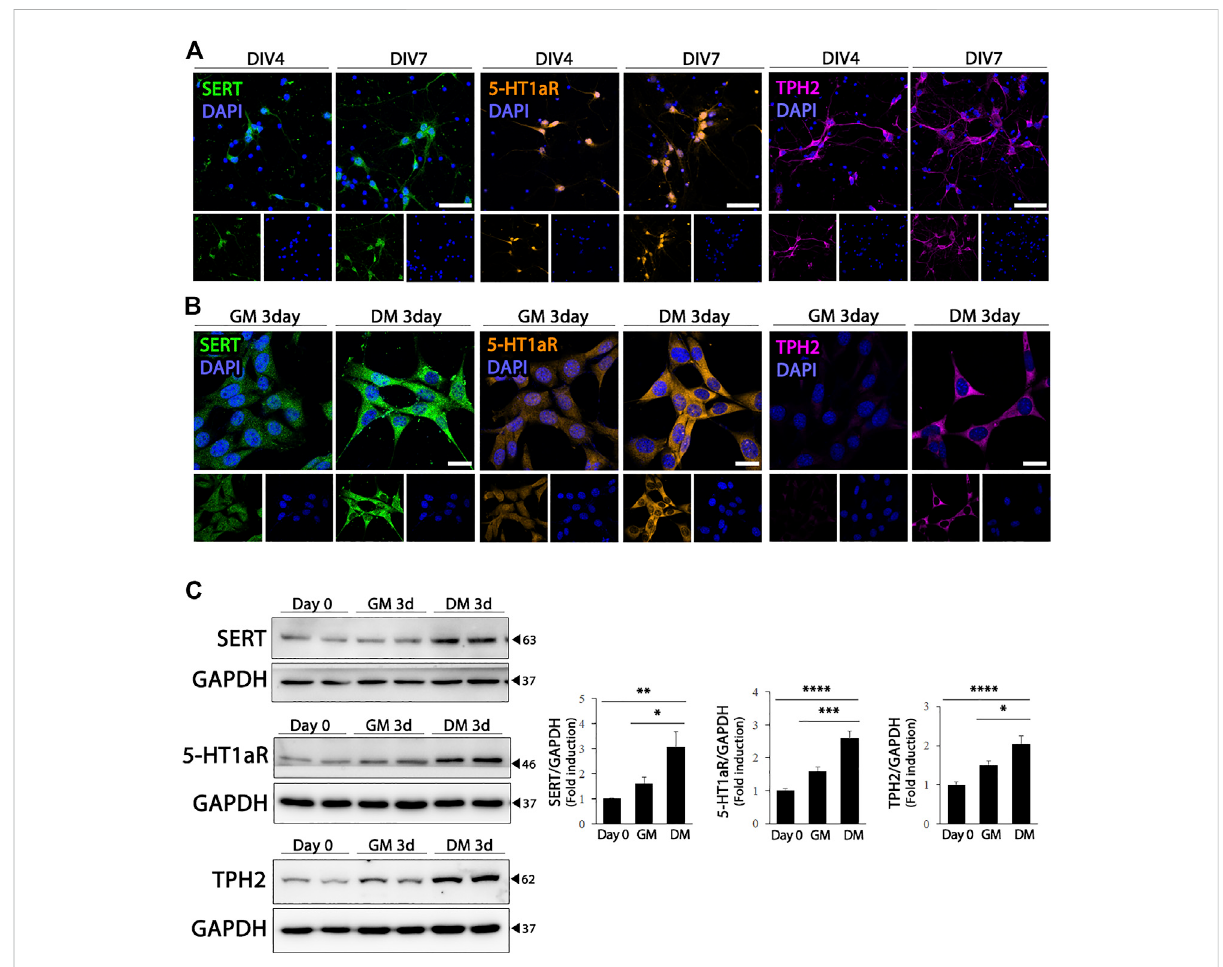
FIGURE 2 Enhanced serotonergicphenotypes ofdifferentiatedHT22 cells. (A) Immuno fl uorescence stainingofSERT(green),5-HT 1a R(orange)andTPH2 (magenta) in hippocampal primary culture. DAPI staining (blue) indicates the nucleus. Scale bar = 50 μ m. (B,C) SERT (green), 5-HT 1a R (orange) and TPH2 (magenta) immuno fl uorescence staining (B) and western blotting (C) of HT22 cells grown in normal growth medium and differentiation medium for3d.DAPIstaining(blue)indicatesthenucleus. Scalebar=25 μ m.GAPDHwasusedas